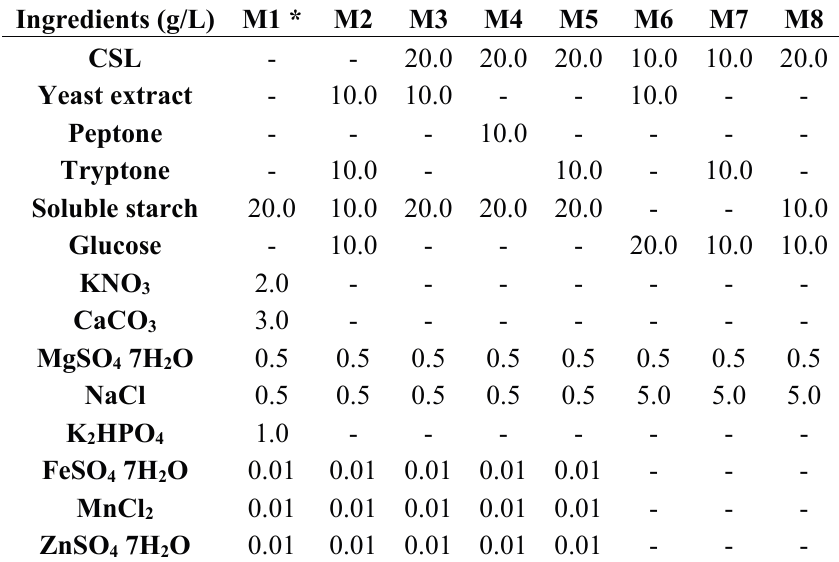
Table 4. Ingredients of different fermentation